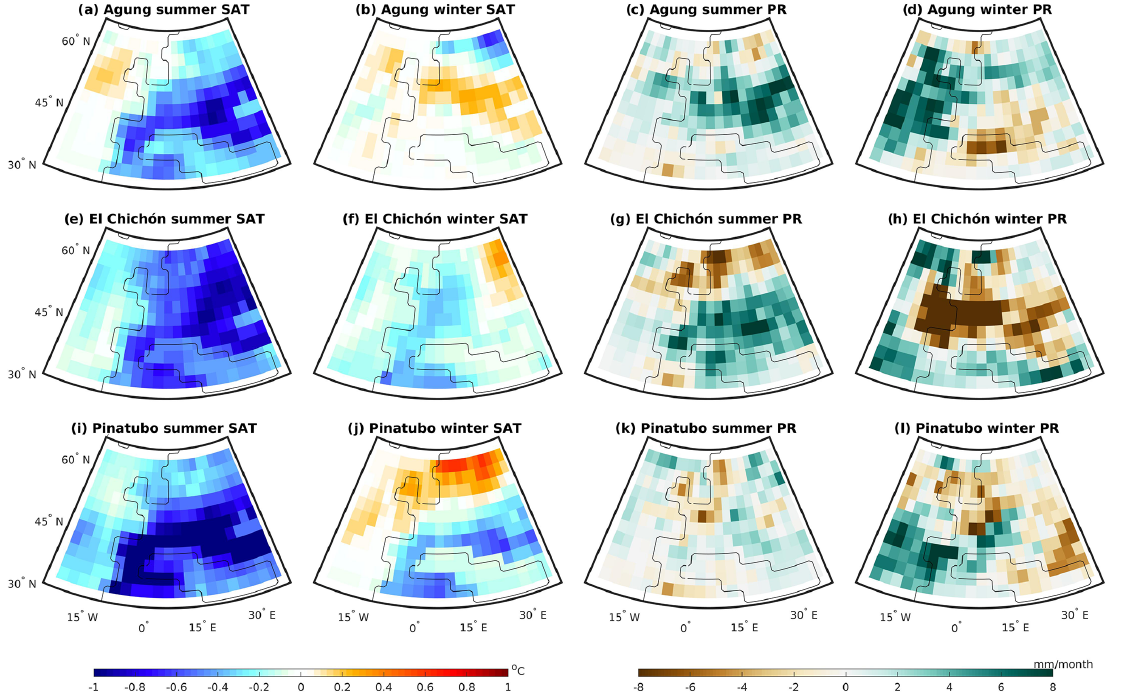
Figure 7. Surface air temperature (SAT) for the summer (a, e, i) and winter (b, f, j) and precipitation for summer (c, g, k) and winter (d, h, l) 1 year after (a–b) Agung, (c–d) El Chichón, and (e–f) Pinatubo shown for the nat-GCM. Anomalies are shown relative to the 5-year period directly prior to the eruptions. The years plotted are 1964, 1983, and 1992 respectively (for winter this is 1963/64, 1982/83, and 1991/92) similar to Fischer et al. (2007). Continental boundaries are shown for the GCM native